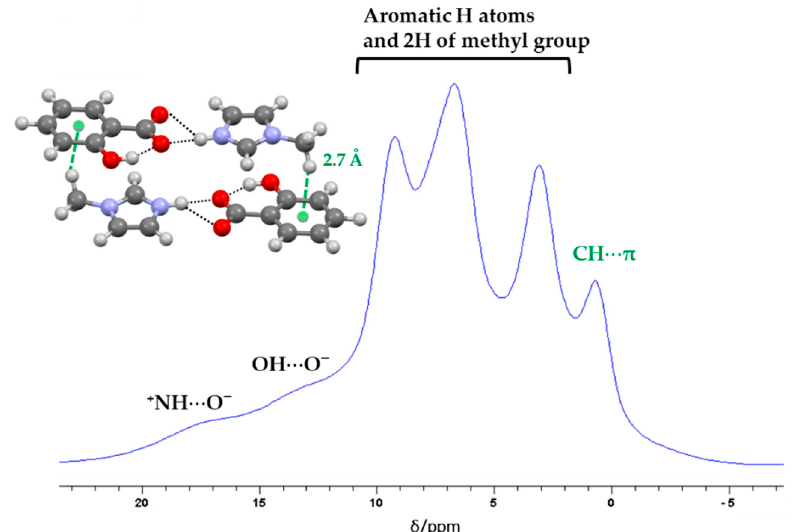
Figure 6. 1 H MAS NMR spectrum of SA:1-MEIM with signal attribution obtained from the correlation between δ iso(exp) and σ iso . See experimental section for acquisition details and supplementary material. SA:1-MEIM layer is also displayed, highlighting the weak C-H (IMI) ⋯ π (SA) interaction.